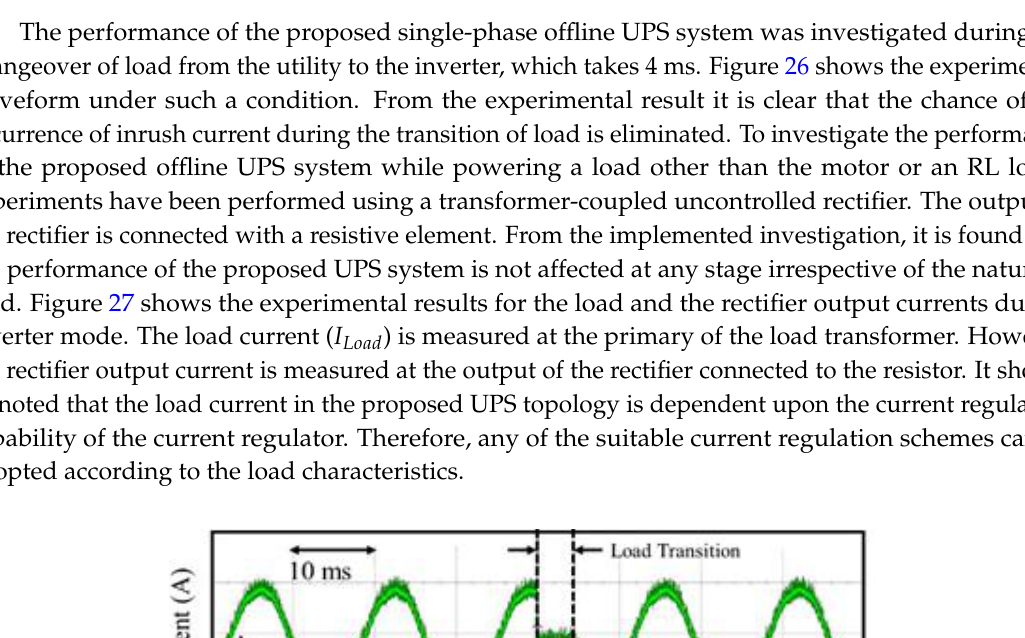
Figure 25. Experimental setup of the proposed single-phase offline UPS system.